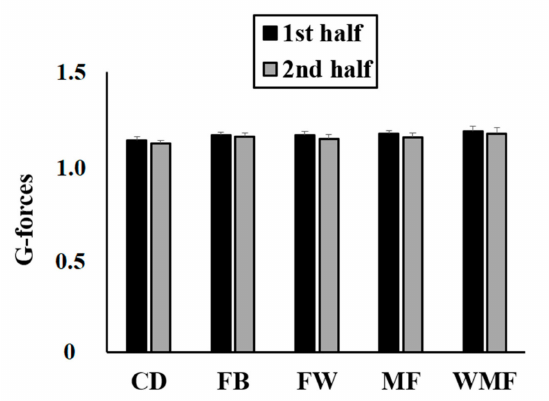
Figure 5. G-forces experienced by elite soccer players based on playing position and match half.